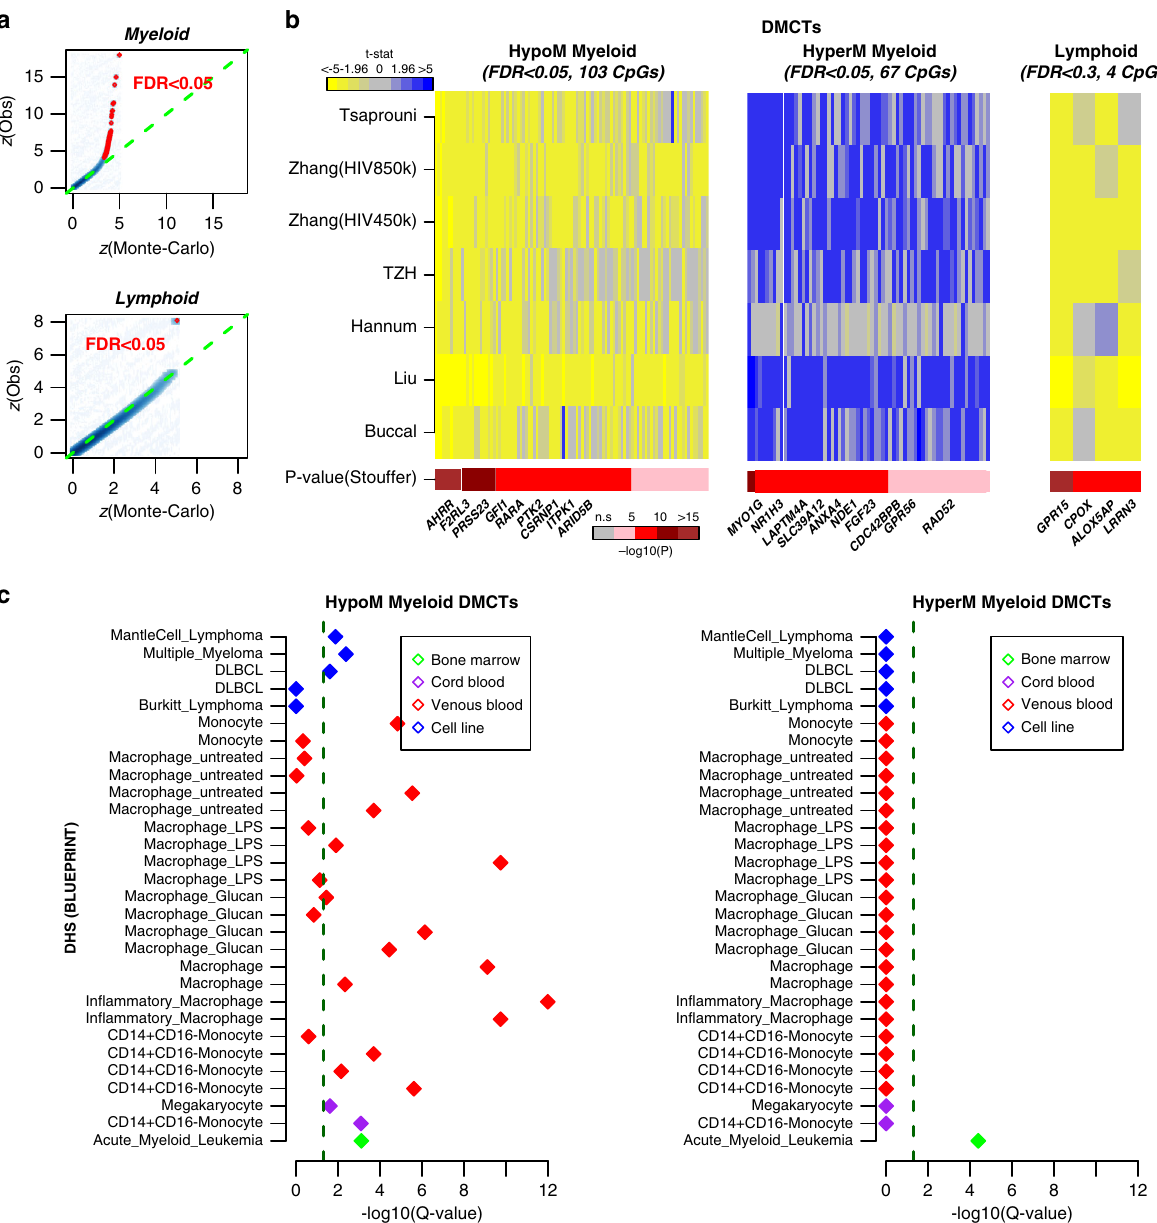
Fig. 4 Myeloid and lymphoid DMCTs as revealed by meta-analysis. a Smoothed scatterplots of the expected quantile of the absolute z -statistic in the meta-analysis, as inferred from a Monte-Carlo permutation analysis ( x -axis) vs. the observed quantile ( y -axis). CpGs that passed an FDR < 0.05 thresholds are shown in red. b Heatmaps of CellDMC t -statistics for myeloid and lymphoid DMCTs, that were deemed statistically signi fi cant in a meta-analysis over the seven studies, as indicated by the Stouffer-test P value. For the myeloid lineage, we used a FDR < 0.05 threshold and only display DMCTs which were consistently hypomethylated or consistently hypermethylated across at least six of the seven studies. For the lymphoid lineage, an FDR < 0.3 threshold was used. c eFORGE enrichment analysis results on the myeloid hypomethylated and hypermethylated DMCTs. The y -axis labels the cell-types for which enrichment of DNase Hypersensitive Sites (DHSs) among the hypo-and-hypermethylated DMCTs was tested. x -axis labels − log 10 ( q -value), where the q -value is the FDR estimate. The green dashed line indicates the signi fi cance threshold FDR < 0.05. Nature of cell-types is labeled by color, as indicated. DLBCL diffuse large B-cell lymphoma, LPS